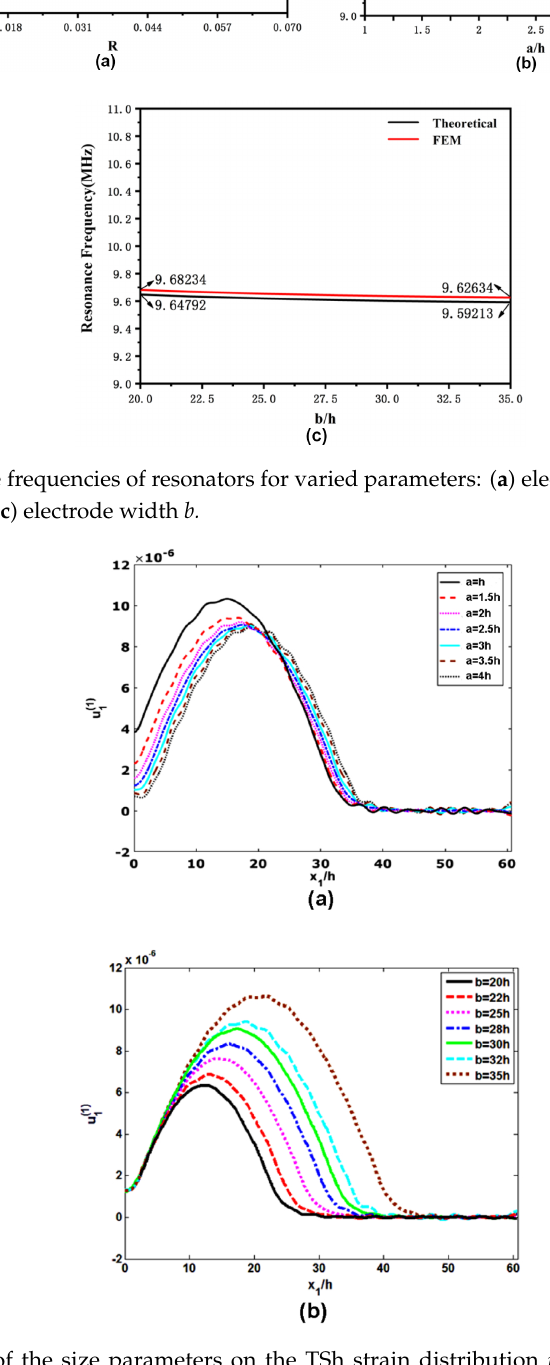
Figure 10. E ff ects of the size parameters on the TSh strain distribution u Figure 10. Effects of the size parameters on the TSh strain distribution ( b ) electrode width electrode width b.